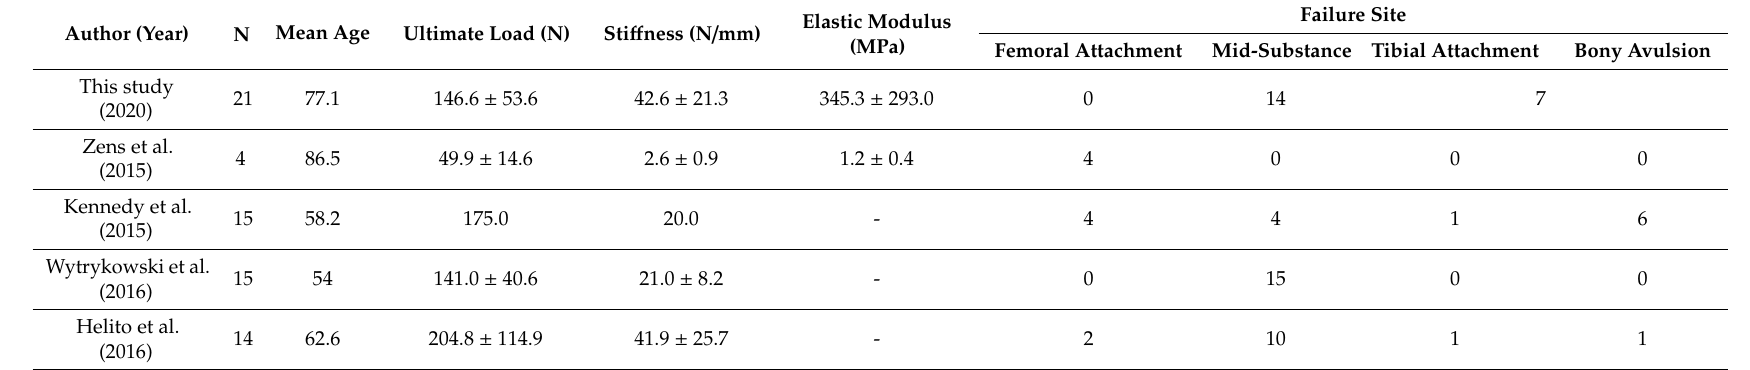
Table 6. Comparisons of the mechanical properties and failure sites of the ALL across the